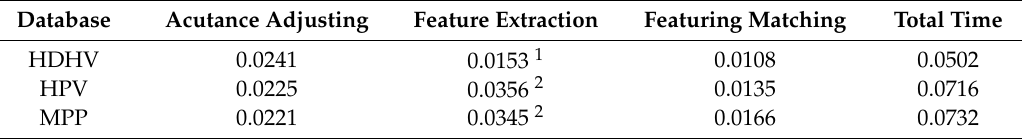
Table 3. Computation time (in seconds) of every stage in general hyperspectral / multispectral hand recognition (sans ROI